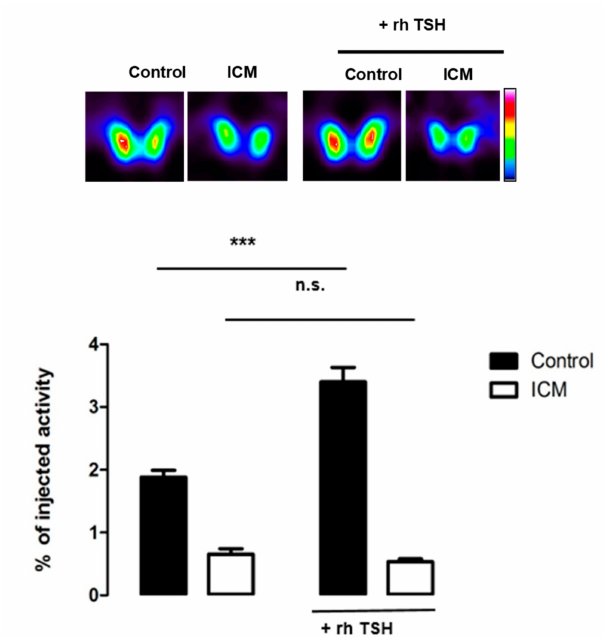
Figure 7. 99m Pertechnetate thyroid uptake on control and ICM-treated animals before and after recombinant human thyroid-stimulating hormone (TSH) administration. SPECT / CT imaging on control and ICM-treated mice was performed before and 24 h after intraperitoneal administration of 3.2 µ g / mouse of TSH. The data represent the averaged values of radiotracer accumulation in the thyroid at 60 min (n = 4 per group). ns: not statistically significant; ***: p <